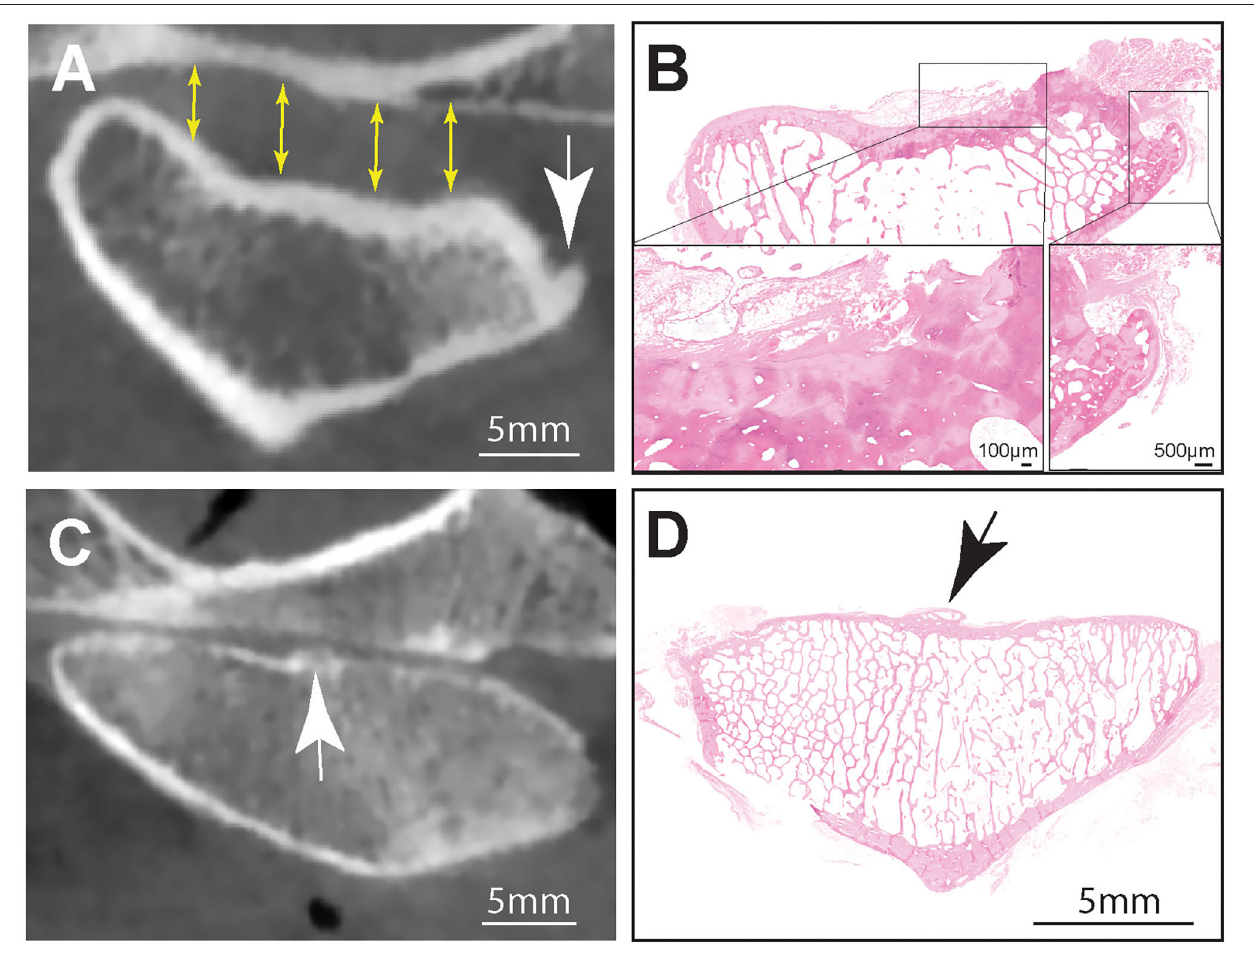
FIGURE 2 | (A) Representative transverse CBCT image of the TMJ of a dog exhibiting increased joint space (yellow arrows), subcondral bone erosion and an osteophyte at the medial aspect of the mandibular head (white arrow). Note that there was excellent agreement between osteophytes found on CBCT and histology (B). Hematoxilin & Eosin staining of the entire mandibular head shown in (A) . Note surface cartilage damage and large laterally located osteophyte. Inset (right) higher magnification of the osteophyte. Bar = 500 µ m, Inset (left) Higher magnification of the sclerotic subchondral bone denuded from surface cartilge. The defect is overlayed by loose fibrous connective and adipose tissue. (C) A CBCT image of an osteophte present on the articular surface of the mandibular head (white arrow) of a dog had excellent agreement with histology (black arrow) (D) . Hematoxilin & Eosin staining of the entire mandibular head. Note centrally located osteophyte (black arrow), Bar =